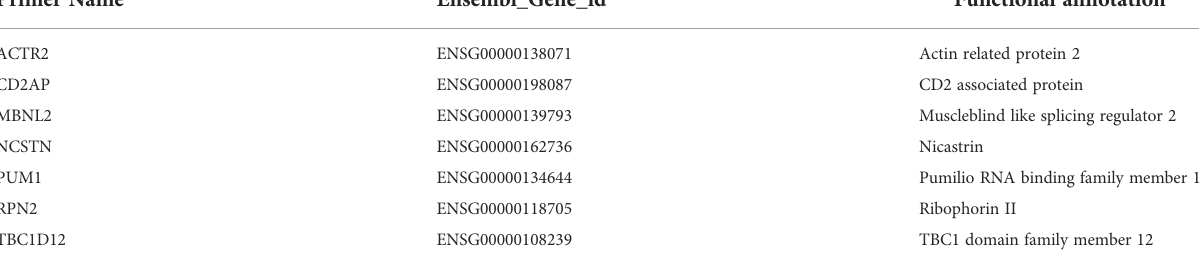
TABLE 2 Functional annotation of feature genes.